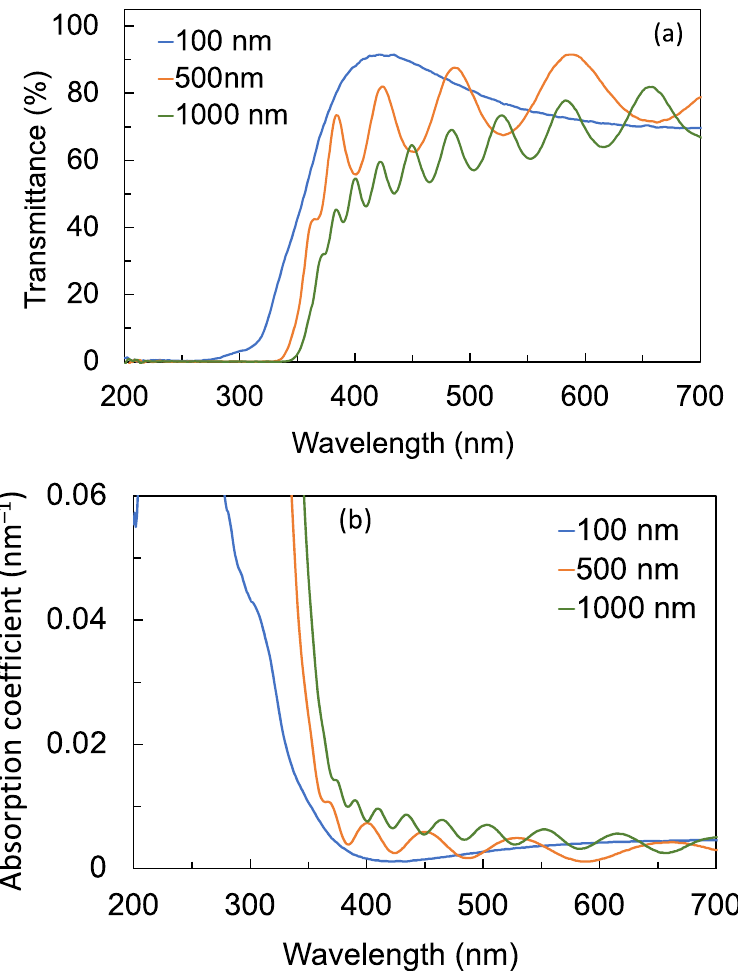
Figure 4. ( a ) Transmission and ( b ) absorption spectra of the TiO 2 films with film thicknesses of 100 nm, 500 nm, and 1000 nm. The Fabry–Perot fringes observed in the spectra are due to multiple reflections from the substrate. Table 2. Transmission edge and band-gap energy of the TiO 2 films with 100 nm, 500 nm, and 1000 nm film thicknesses.